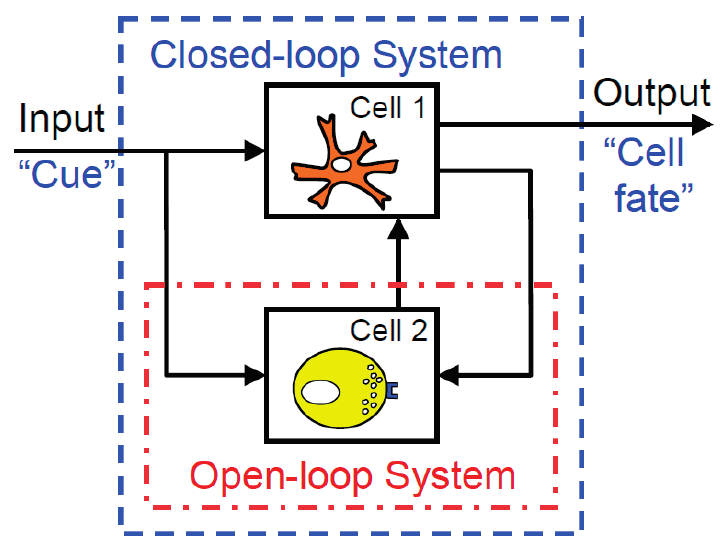
Figure 2. Studying open-loop cellular systems, as indicated by the red open-dash